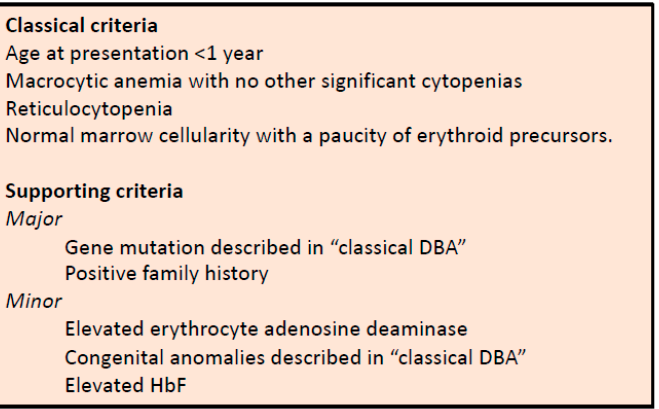
Figure 1. Diagnostic and supporting criteria for the diagnosis of DBA, as established by Vlachos et al.